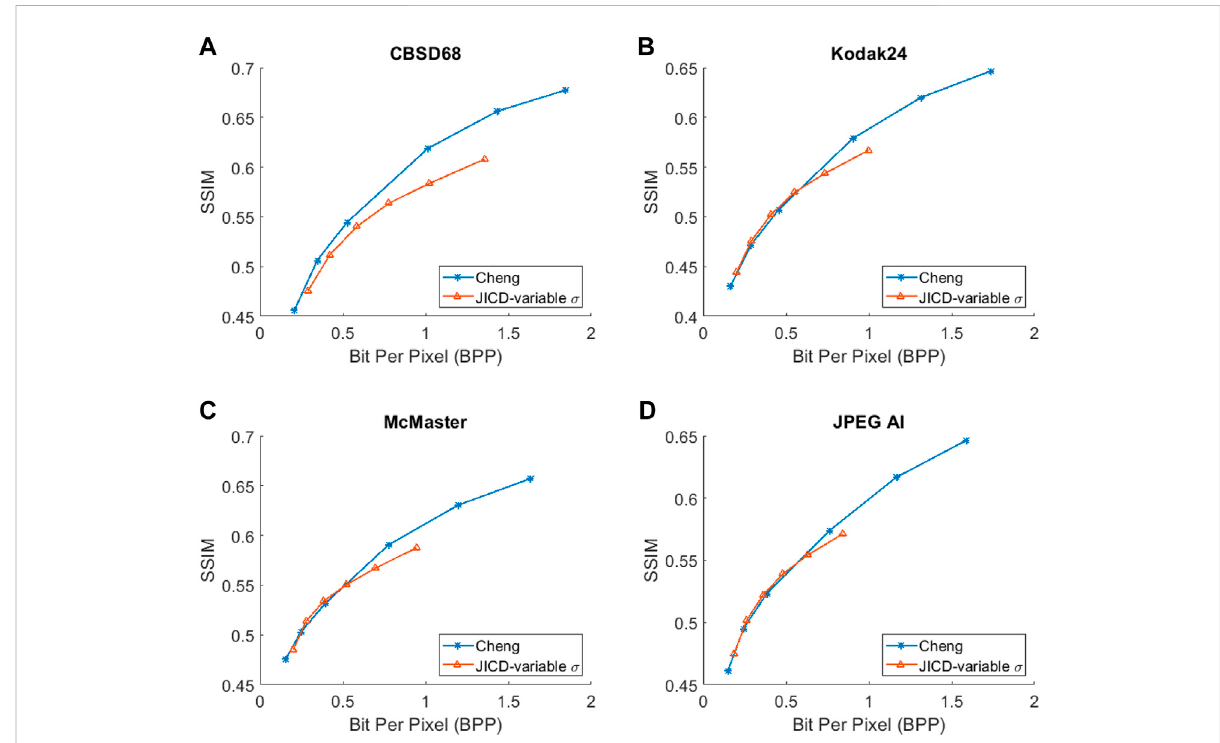
FIGURE 13 The rate-SSIM curves for noisy input reconstruction. (A) CBSD68, (B) Kodak24, (C) McMaster, (D) JPEG-AI.